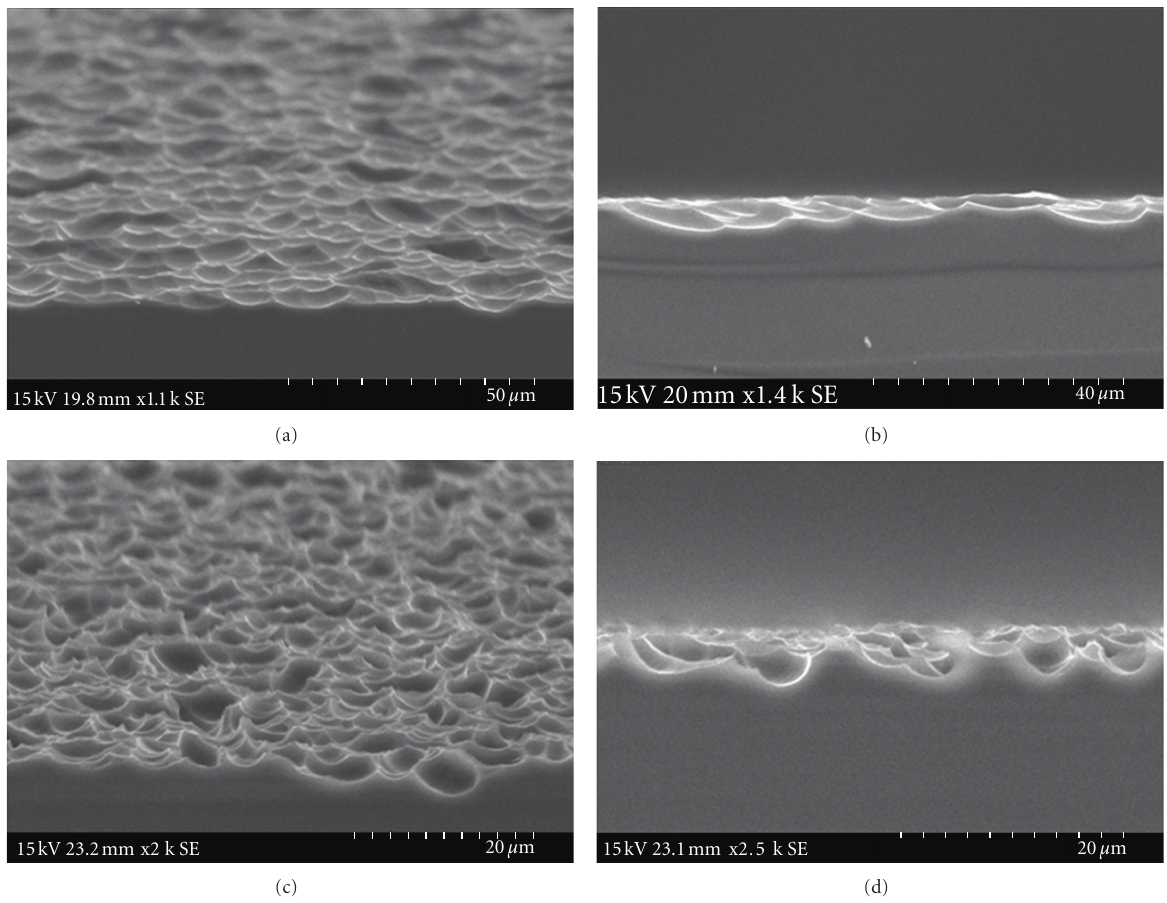
Figure 7: Scanning electron microscope images of the surface and cross sections of multicrystalline silicon wafer surfaces textured under two di ff erent conditions: (a,b) HF:HNO 3 :H 2 O = 15: 50:35, 25 ◦ C, 2min; (c,d) HF :HNO 3 :H 2 O = 24:40 :36, 10 ◦ C,